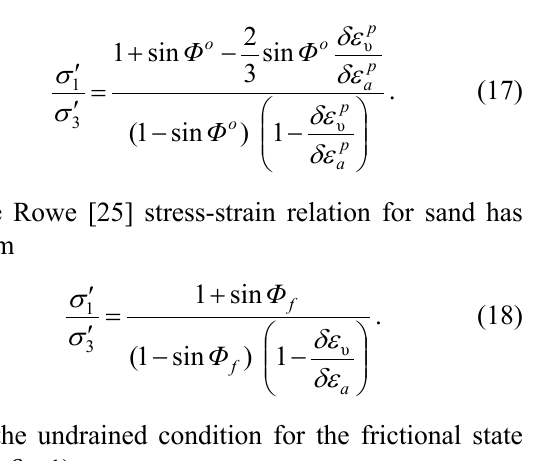
Fig. 13. Stress ratio-dilatancy at failure of River Walland sand